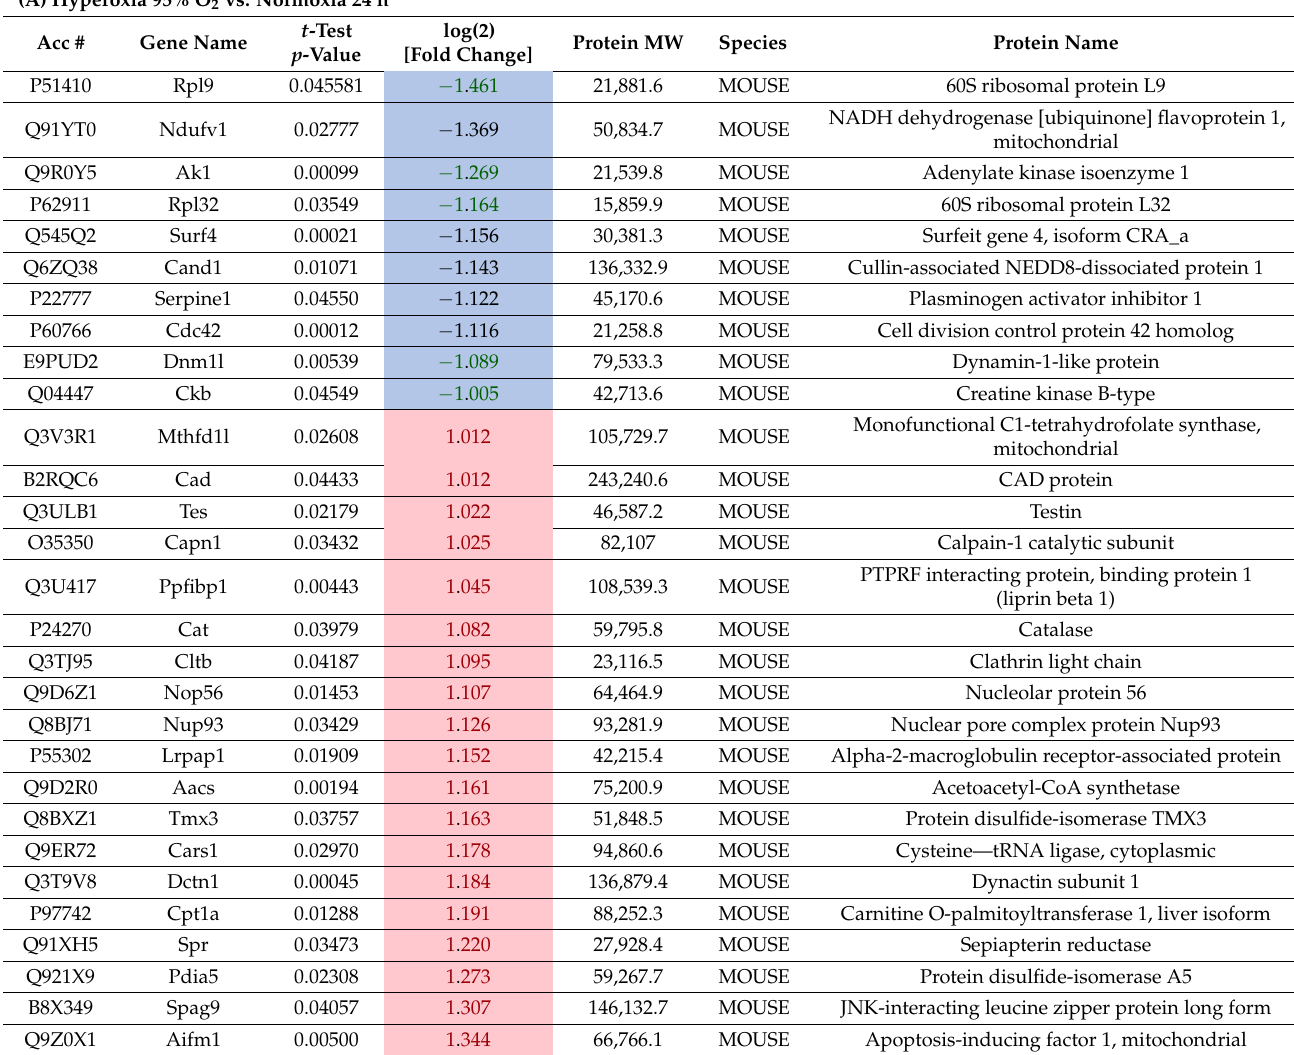
Table 1. Differentially expressed proteins (DEPs) after 24 h and 72 h exposure to constant severe hyperoxia. Murine lung endothelial cells were exposed for 24 h ( A ) and 72 h ( B ) to 95% O 2 . Semi- quantitative proteomic analysis revealed statistically significant changes in protein expression (blue: downregulated DEPs; red: upregulated DEPs). Results are log(2) fold changes compared to exposure under 21% O 2 for the same period of time. Statistical evaluation: two-sample t -test assuming unequal variances.